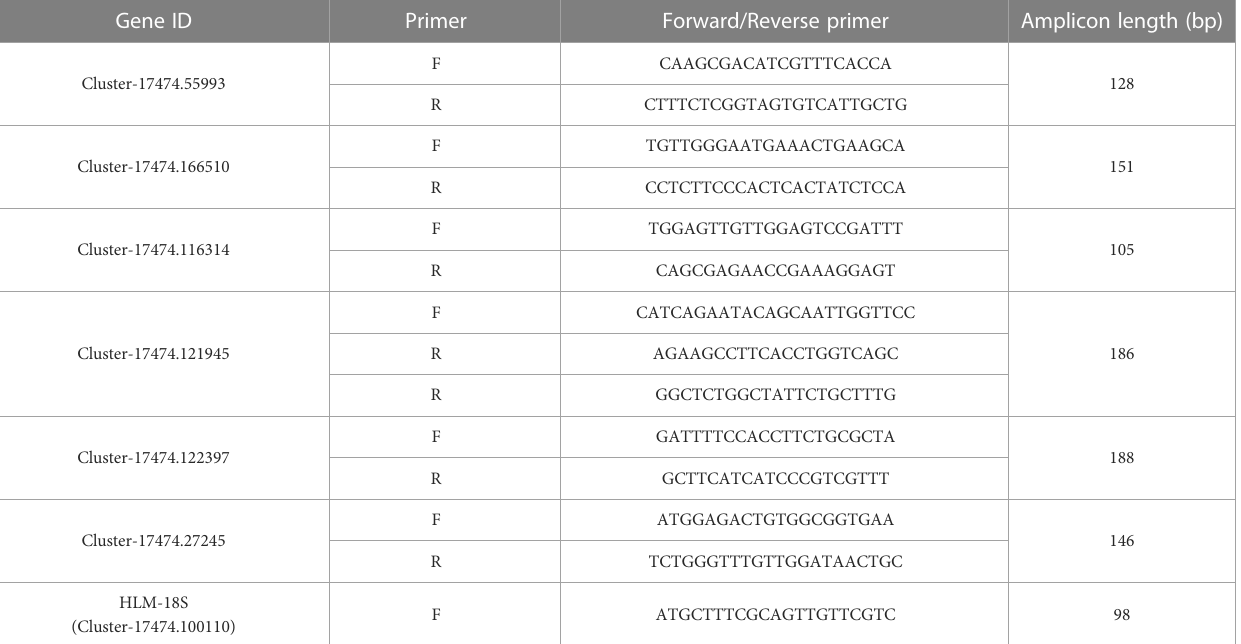
TABLE 1 Primers for qRT −